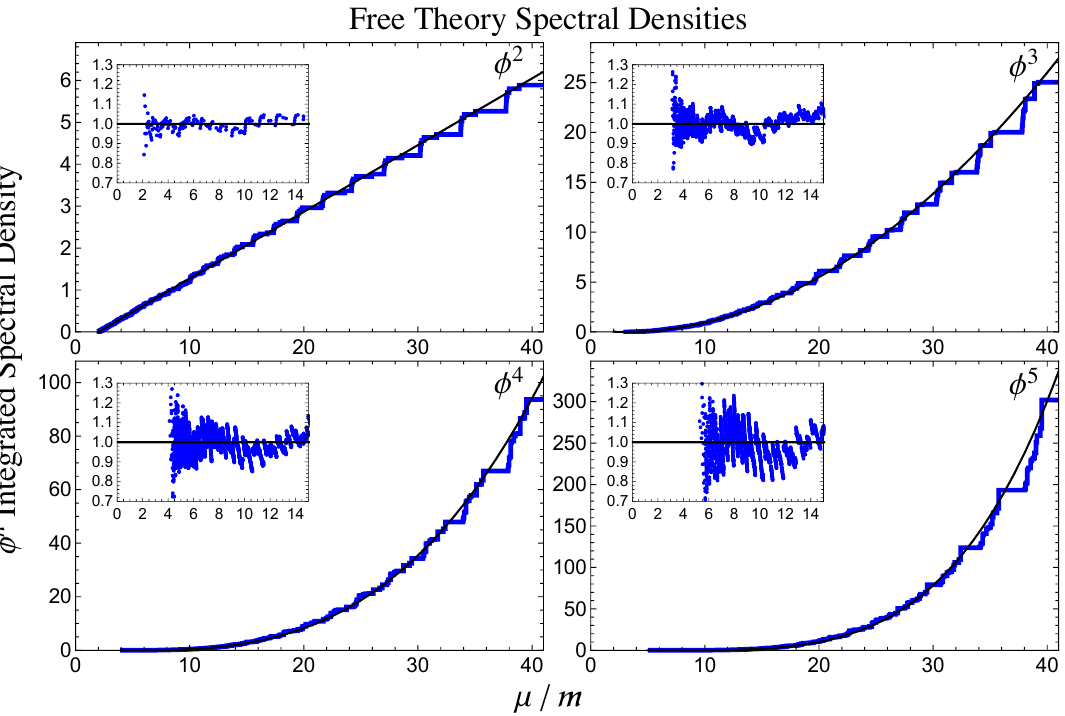
Figure 3 . Integrated spectral densities of φ 2 (top left), φ 3 (top right), φ 4 (bottom left), and φ 5 (bottom right) in free massive field theory ( g = 0 ). Each plot shows the LCT data (blue), computed using ∆ = 16 , i = 65 , Λ IR = 0 . 5 , and r = 0 . 8 (corresponding to Λ UV max max m known analytical result (black line). The insets show the ratio of the data to the analytical